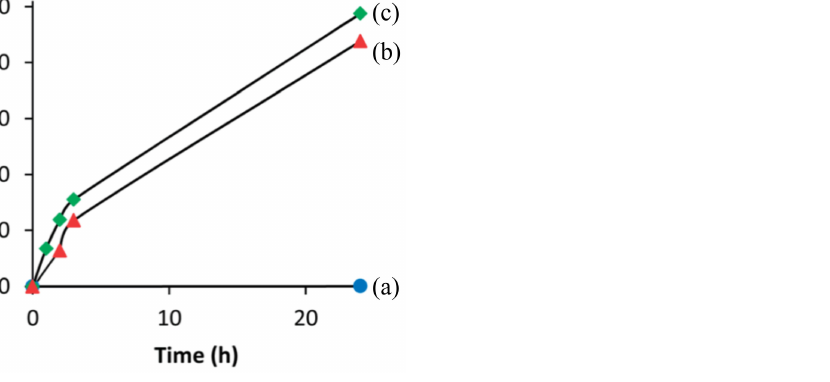
Figure 17. Benzyl chloride conversion in benzylation of toluene as a function of time at 403 K for ( a ) IEZ-Al-CDO, ( b ) Fe-IEZ-CDO, and ( c ) Fe-IEZ-Al-CDO. Reprinted with permission from ref. [65]. Copyright 2014, Royal Society of Chemistry.